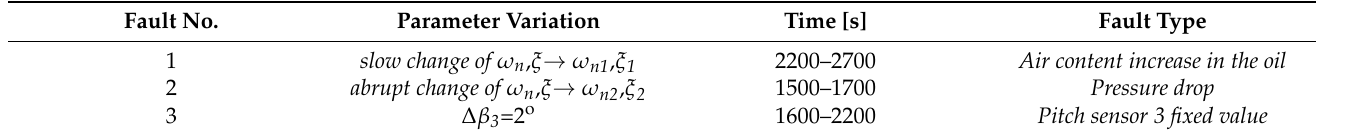
Table 1. Dynamic change resulting from the faulty pitch scenarios. Fault